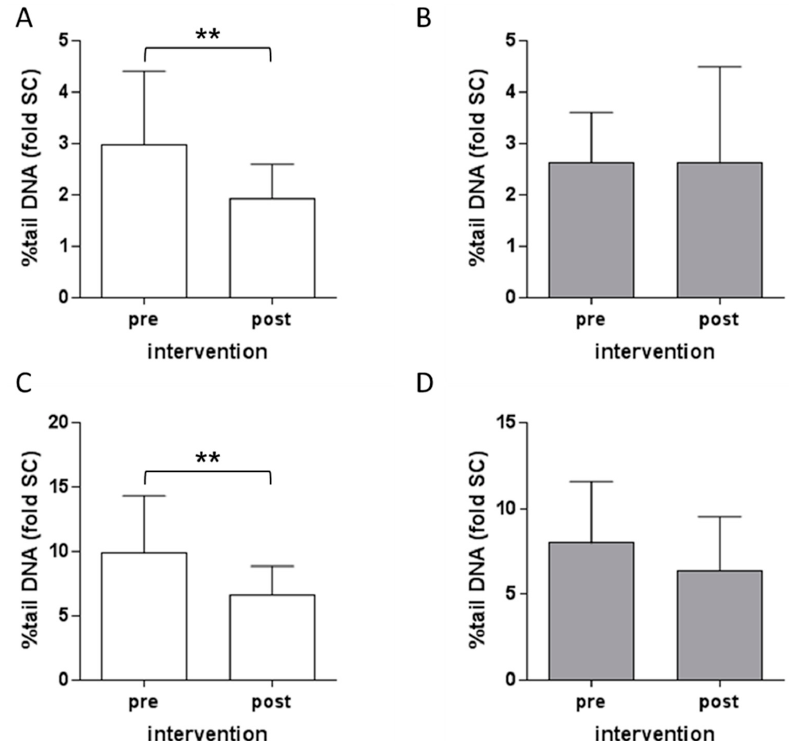
Figure 3. Effect of intervention with B. carinata leaf preparation on DNA damage induction by aflatoxin B1 (AFB1). PBMC were exposed to 10 µM AFB1 for 4 h without ( A , B ) or in the presence of a metabolic activation system ( C , D ) before (pre) and after (post) the intervention with B. carinata . White bars show effects of the intervention with preparations from cooked B. carinata leaves ( − ITC), grey bars show effects of the intervention with preparations from raw B. carinata leaves (+ITC) as fold of control (SC = 0.1% DMSO). Data are means ± SD ( n = 22). Asterisks indicate statistically significant differences (** p ≤